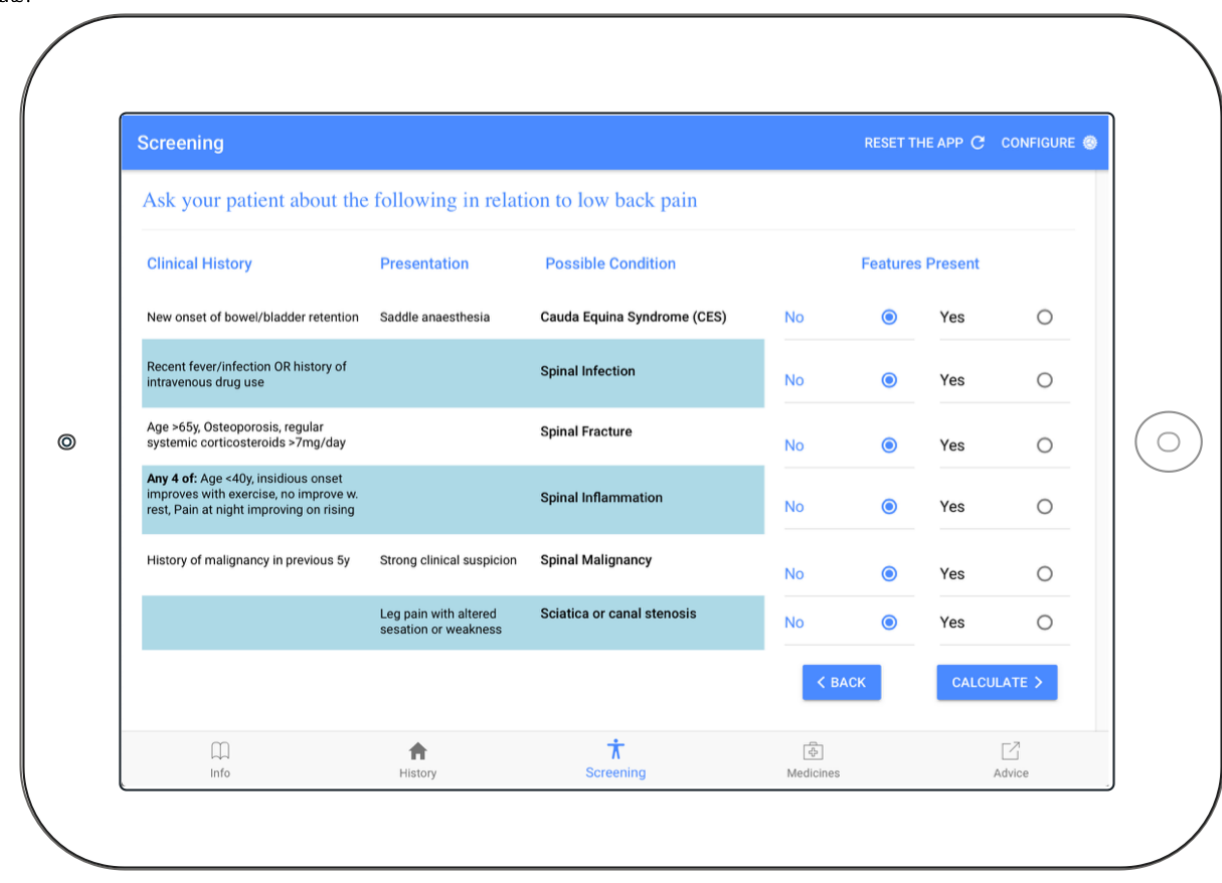
Figure 3. Clinical decision support system screening page for raising suspicion of a serious cause of low back pain. The “No” response is the default